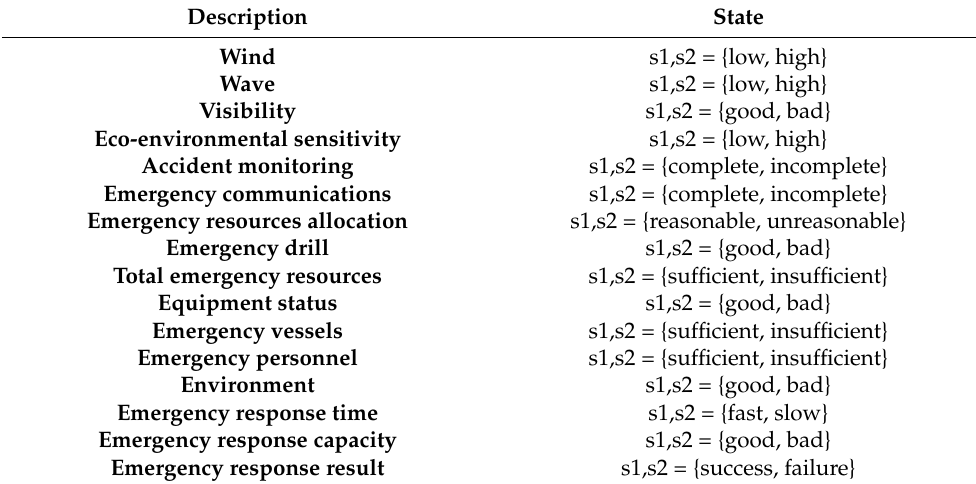
Table 2. The description and discretization of the nodes in the Bayesian network model.